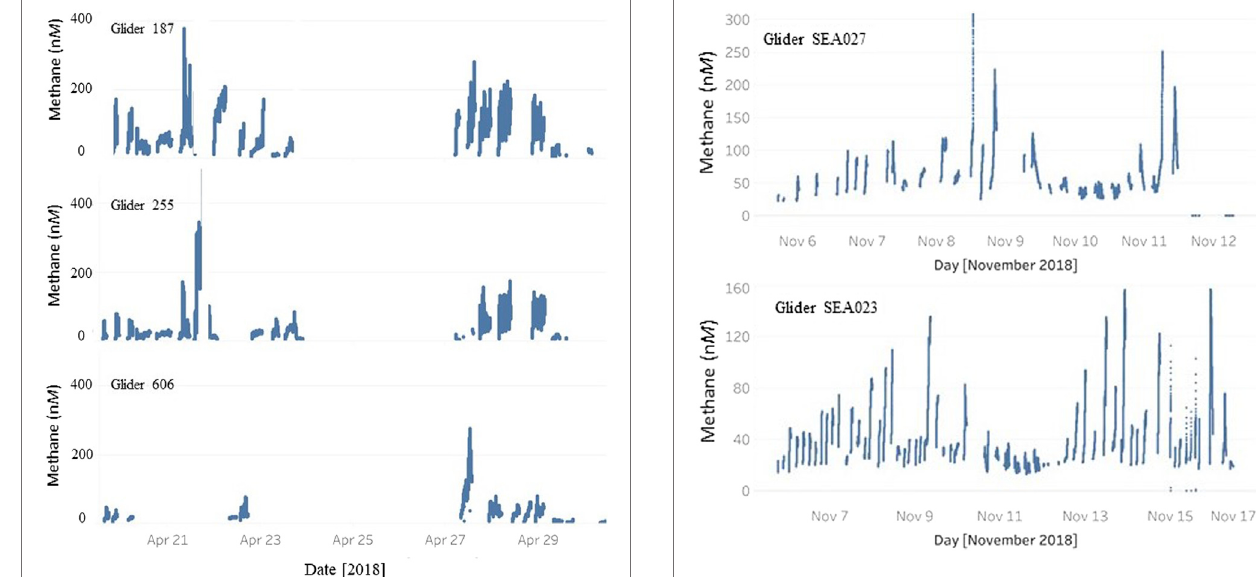
FIGURE 4 | Methane concentrations measured by gliders SEA023 and SEA027 during the fall study. Data has been fi ltered to eliminate measurements taken above 450 m below the sea